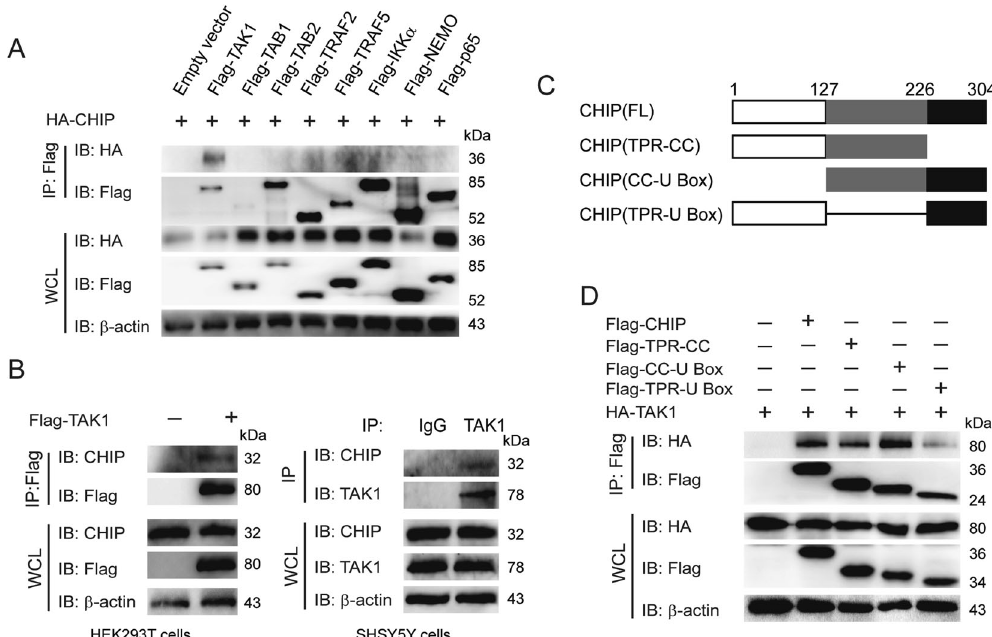
Fig. 3 CHIP interacts with TAK1. A CHIP interacts with TAK1. HEK293T cells were transfected with HA-CHIP and an empty vector, Flag-TAK1, Flag-TAB1, Flag-TAB2, Flag-TRAF2, Flag-TRAF5, Flag-IKK α , Flag-NEMO, or Flag-p65, and the cell lysates were detected by co- immunoprecipitation and immunoblotting. B CHIP interacts with TAK1. Overexpression of TAK1 or endogenous TAK1 interacted with endogenous CHIP detecting by co-immunoprecipitation and immunoblotting in HEK293T or SHSY5Y cells. C The domain architecture of CHIP showing different deletion constructs of CHIP. Numbers indicated the amino acid position in construct. D HEK293T cells were transfected with HA-TAK1 and an empty vector, Flag-CHIP or Flag-CHIP domains. The cell lysates were detected by co-immunoprecipitation and immunoblotting. All results were representative of three independent